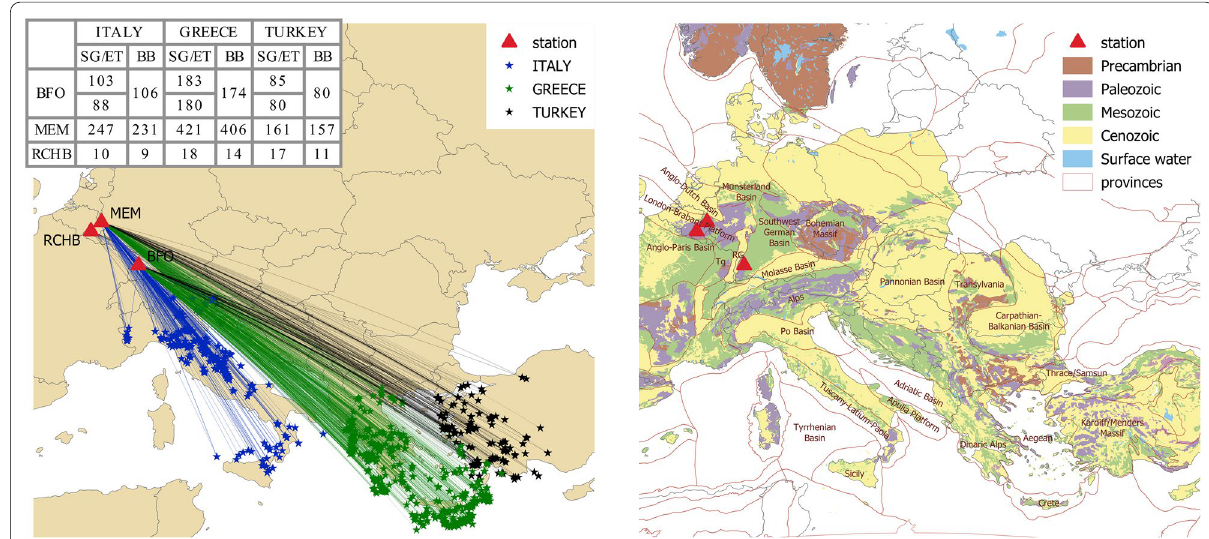
Fig. 1 Distribution of epicentres of earthquakes used in the regional scale analysis of group‑velocity dispersion curves of Rayleigh waves together with great circles of waves propagation (left) and simplified geological map (Pawlewicz et al. 2002) of analysed regions and their surroundings (right). Codes of stations refer to seismic stations; in the left upper corner a summary of the number of events considered for particular regions is shown; RG Rhine Graben, Tg